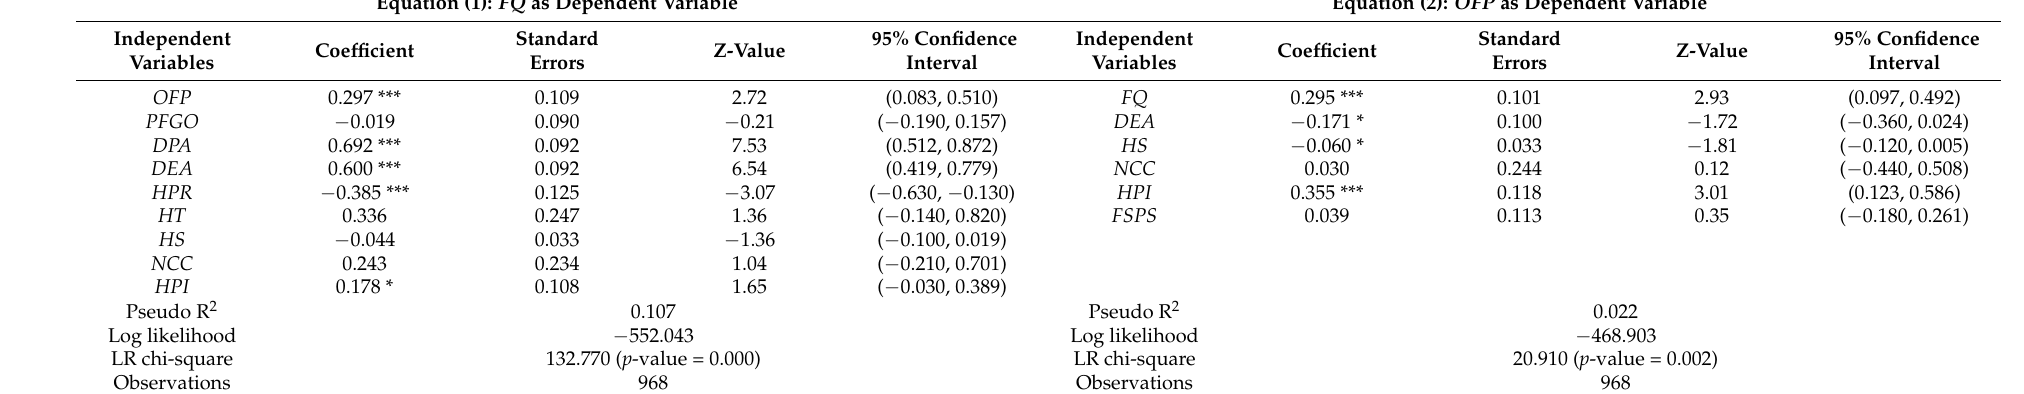
Table 5. Estimated results of simultaneous equations: model III.